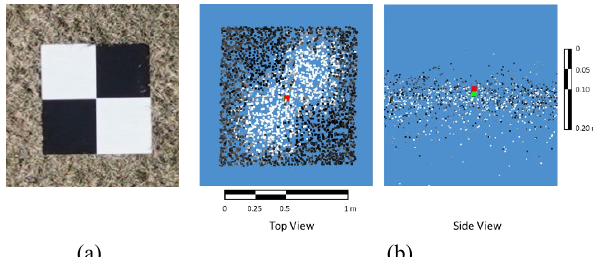
Figure 7. A sample of point correspondence in LiDAR point cloud: (a) a checkerboard target in an RGB image, and (b) the LiDAR points of the checkerboard target, initial point, (red point), and LiDAR-derived center of the target (green point). The LiDAR point cloud is colored by intensity, where points with low and high intensities are shown in black and white,